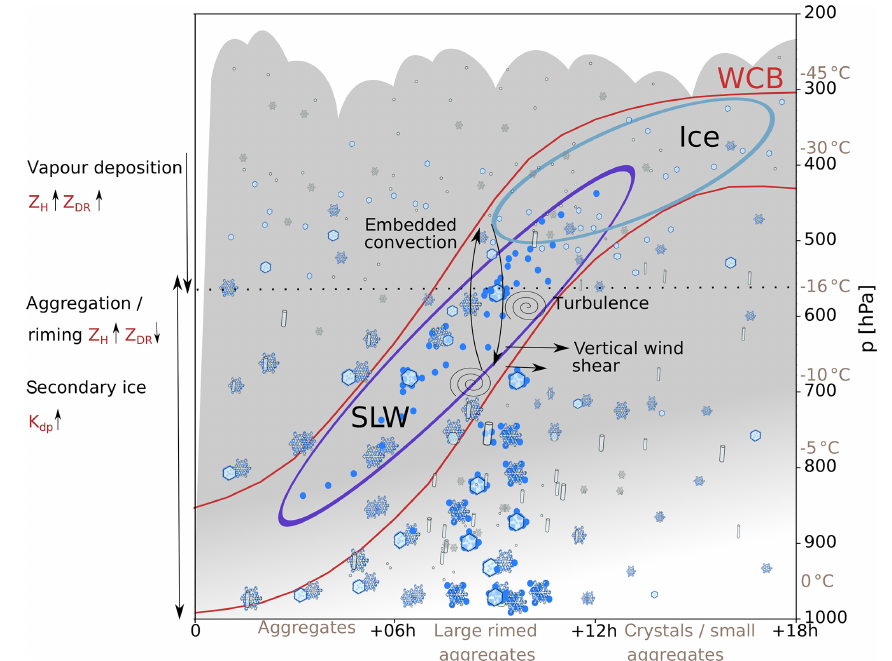
Figure 16. Conceptual model in a Lagrangian reference frame (i.e. along the WCB) summarising the key findings. The temperature in- dications come from the radiosounding at 06:00UTC (Fig. 6a). The time is indicated as hours from the start of the ascent. The ascent is representative of a strong wintertime